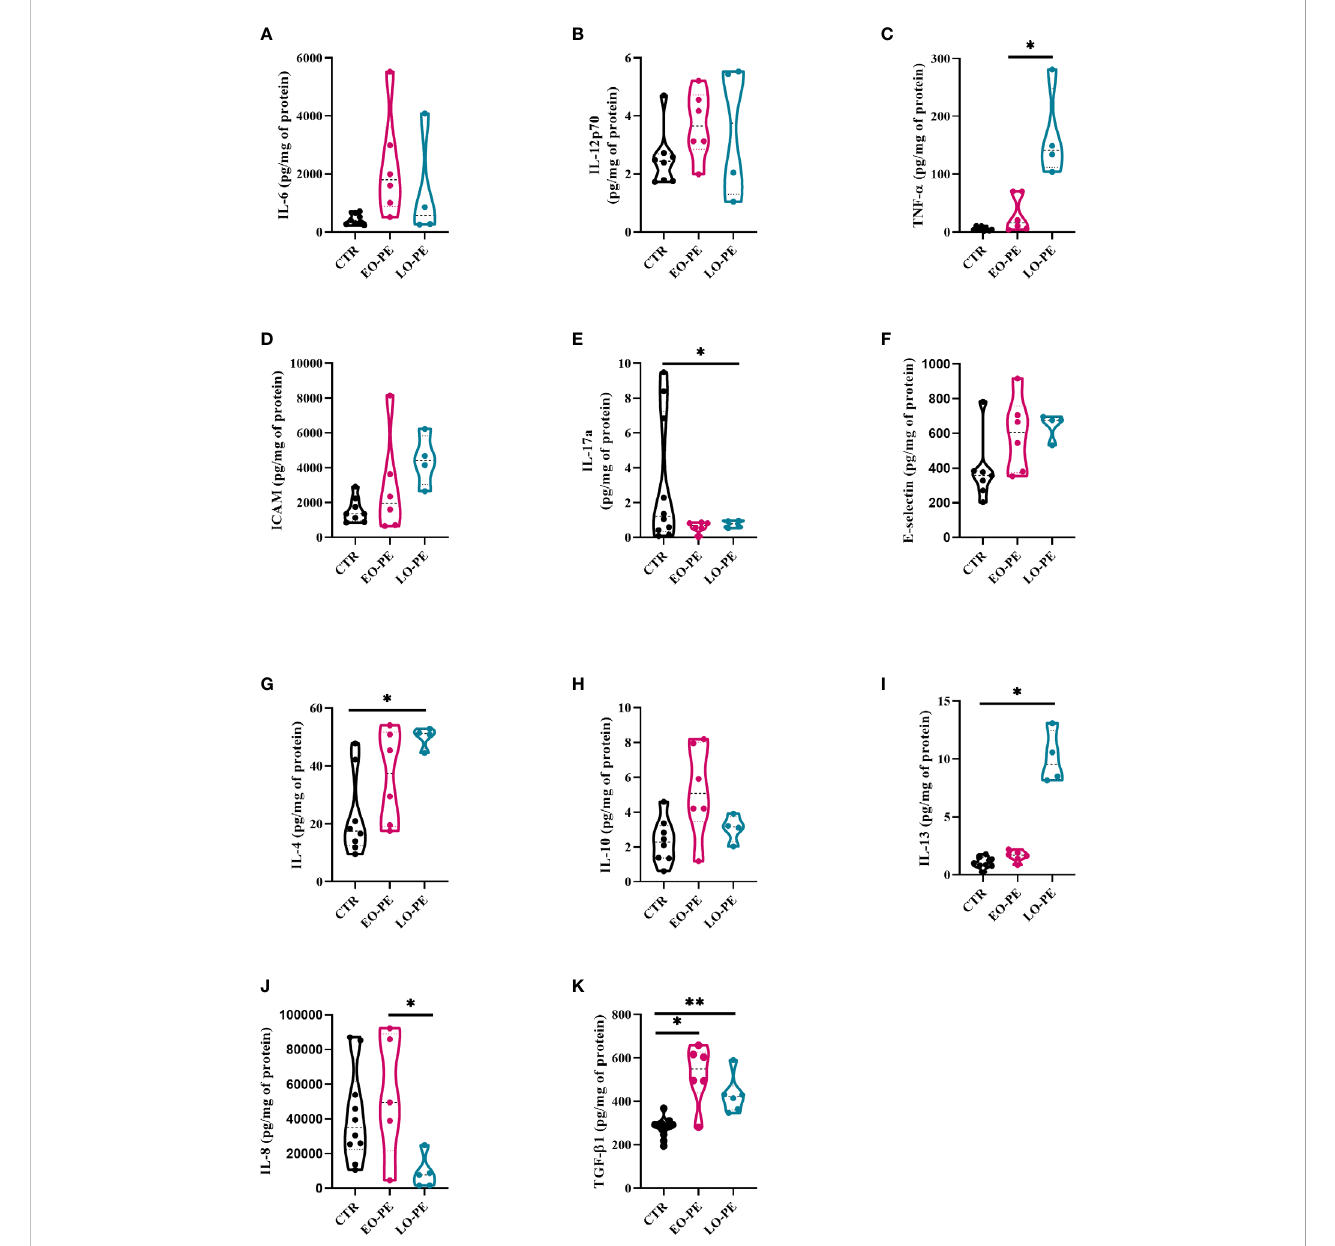
FIGURE 2 Secretion of cytokines and adhesion molecules by CTR (n=8), EO- (n=6) and LO-PE (n=4) HBCs. Multiplex-ELISA-on-beads assay for followed pro- in fl ammatory and anti-in fl ammatory cytokines (A) IL-6, (B) IL-12p-70, (C) TNF- a , (D) ICAM, (E) IL-17a, (F) E-selectin, (G) IL-4, (H) IL-10 and (I) IL-13, respectively. Multiplex was performed in duplicates. (J) ELISA against IL-8 performed in duplicates (CTR n=10, EO-PE n=5 and LO-PE n=5). (K) ELISA assay against TGF- b 1 performed in duplicates (CTR n=12, EO-PE n=6 and LO-PE n=6). Secretion of respective cytokines was normalized to the total protein content measured in the cell culture supernatants. Statistical signi fi cance was tested using ANCOVA with adjustment for gestational age followed by Sidak ’ s post-hoc test. *p ≤ 0.05, **p ≤